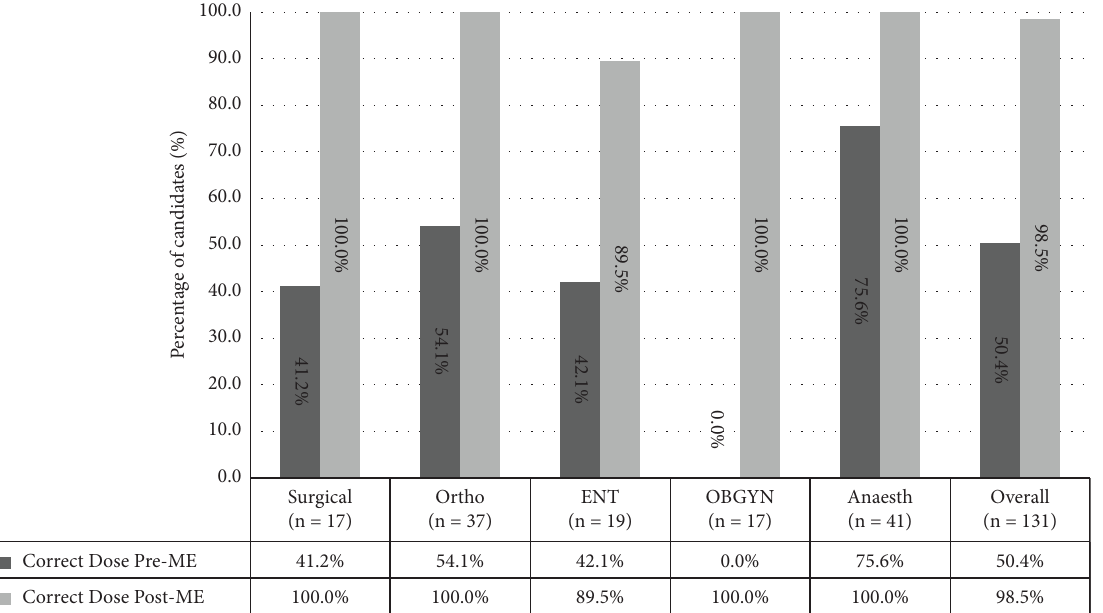
Figure 2: Candidates’ knowledge on maximum recommended dose of lignocaine (plain and with adrenaline); comparing pre-ME results and post-ME results.